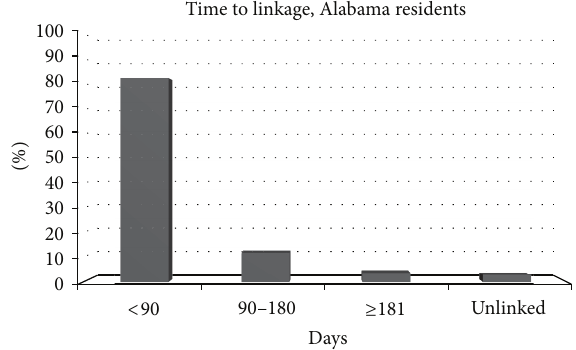
Figure2:TimetoLinkageindaysforHIV+AlabamaResidentswho participated in an integrated linkage program, AL,